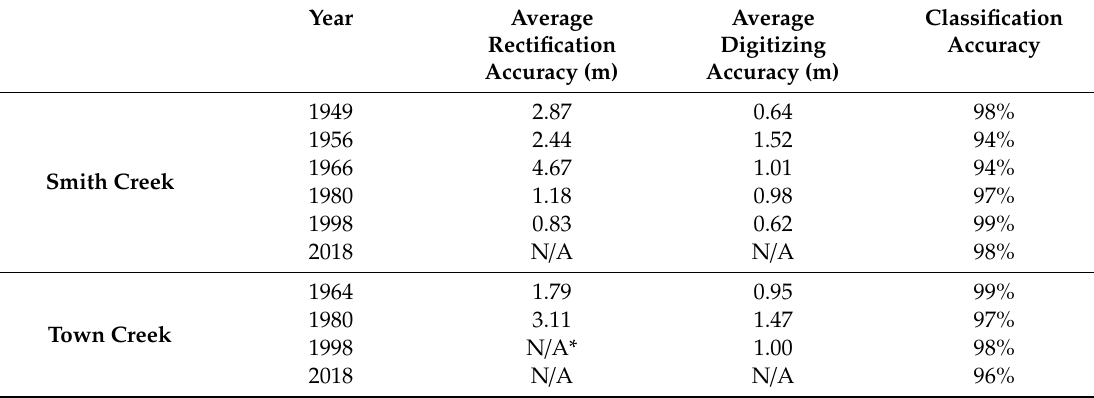
Table 3. Image rectification, digitizing, and classification accuracy by